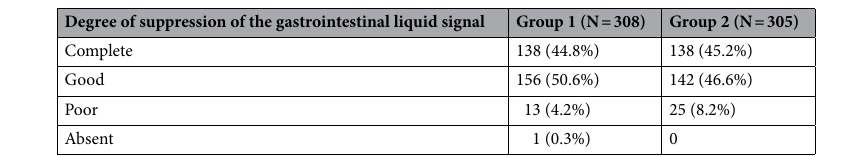
Table 3. Contrast effect based on the degree of suppression of the gastrointestinal liquid signal.